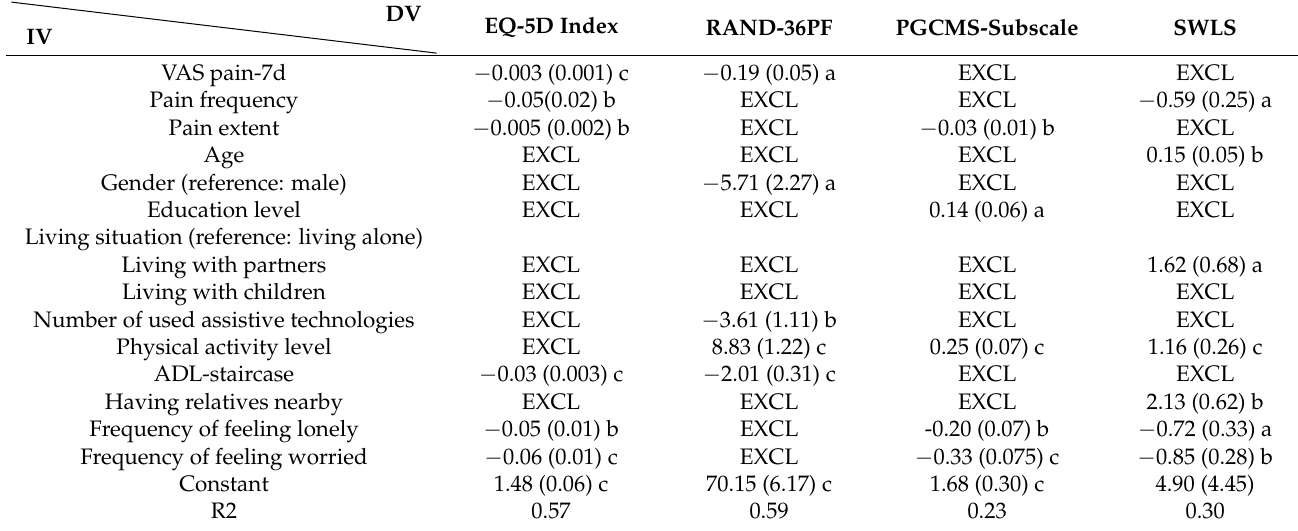
Table 3. Multiple linear regression models of quality of